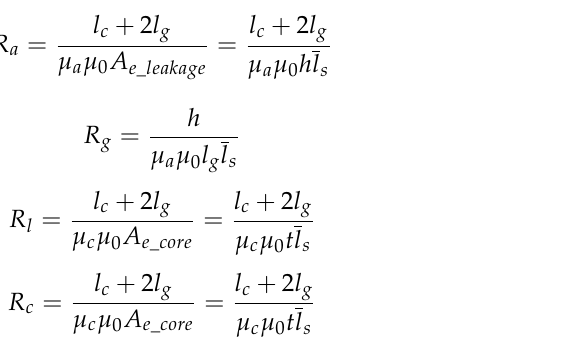
R represents the air a